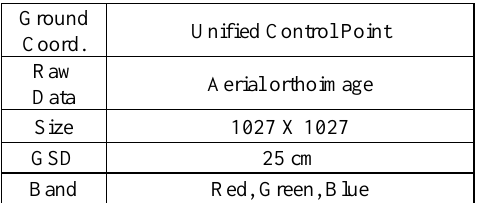
Table 2. Specification of GCP Chips.